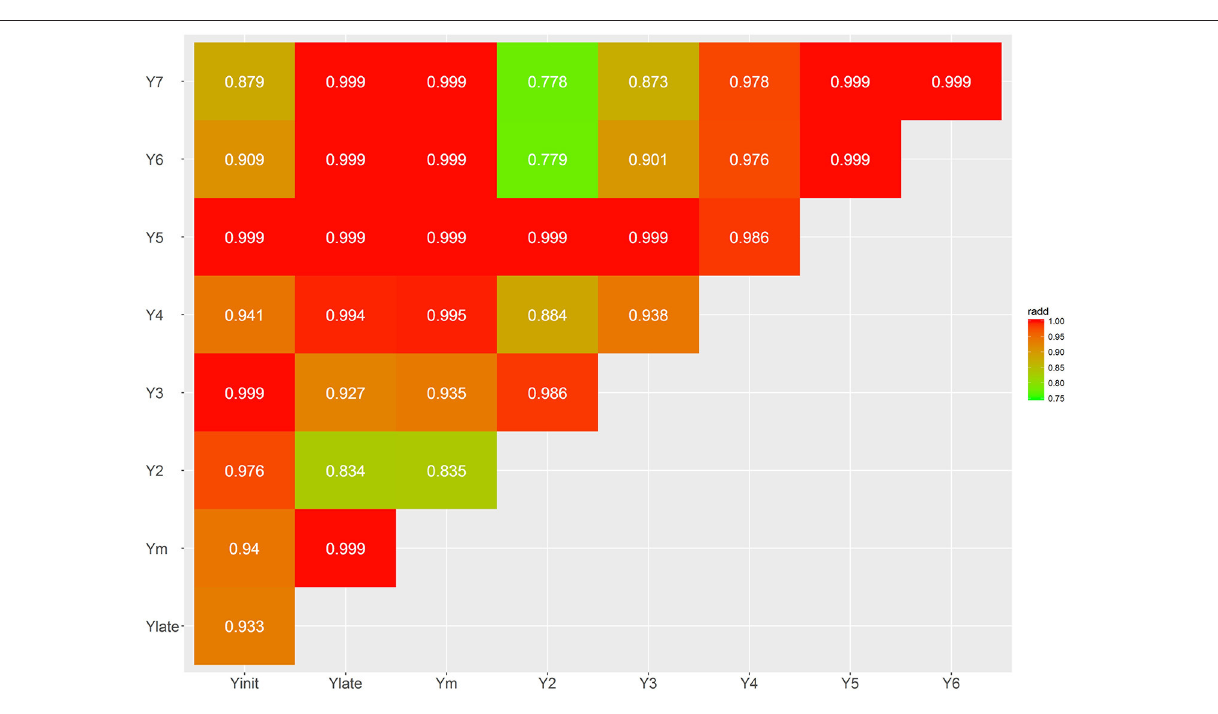
Ym. PA-169, GU-154-L, and IMC-67 are related to low %MO, have low PI, and also have moderate to high Ym. Parents with low jorquette height are Criollo-27, ICS-43, Lc-Teen37, UF-273